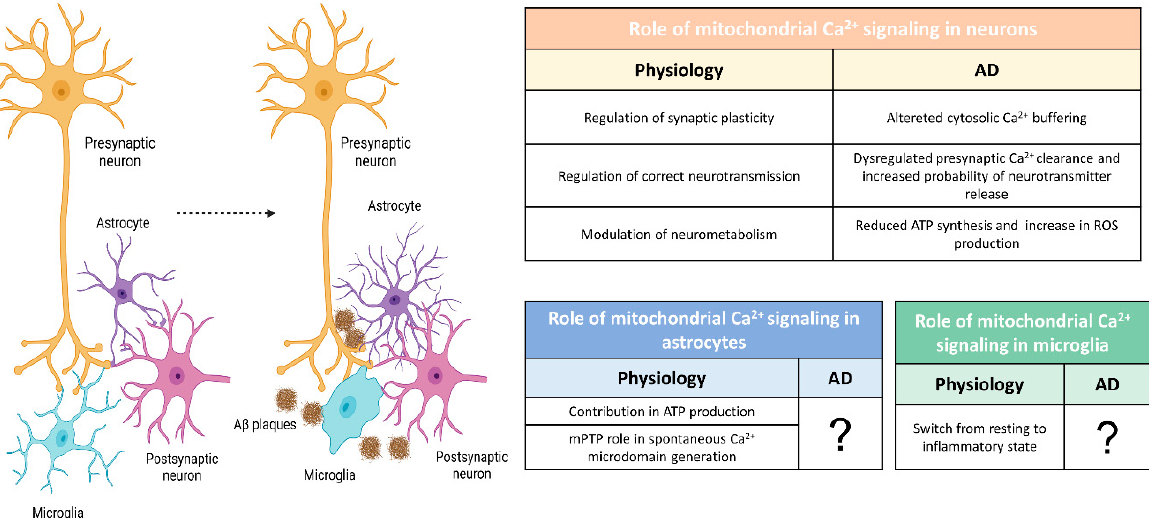
Figure 2. ( Left ), schematic representation of the cellular elements involved in the formation of the quad-partite synapse. Transition from healthy to AD condition with the presence of A β plaques and the morphological changes in astrocytes and microglia. ( Right ), tables reporting the roles of mitochondrial Ca 2+ signaling in neurons, astrocytes and microglia and the reported dysfunctions in different AD samples. This original figure was created by the authors using “BioRender.com” (https://biorender.com, accessed on 7 November 2022).